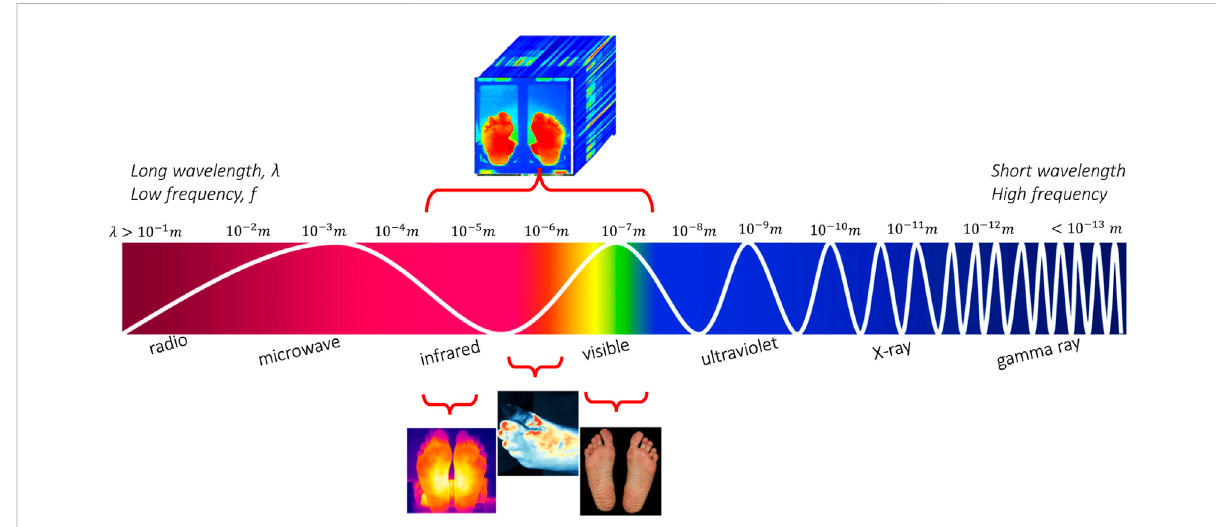
FIGURE 1 The electromagnetic spectrum along with the imagery techniques for the diabetic foot